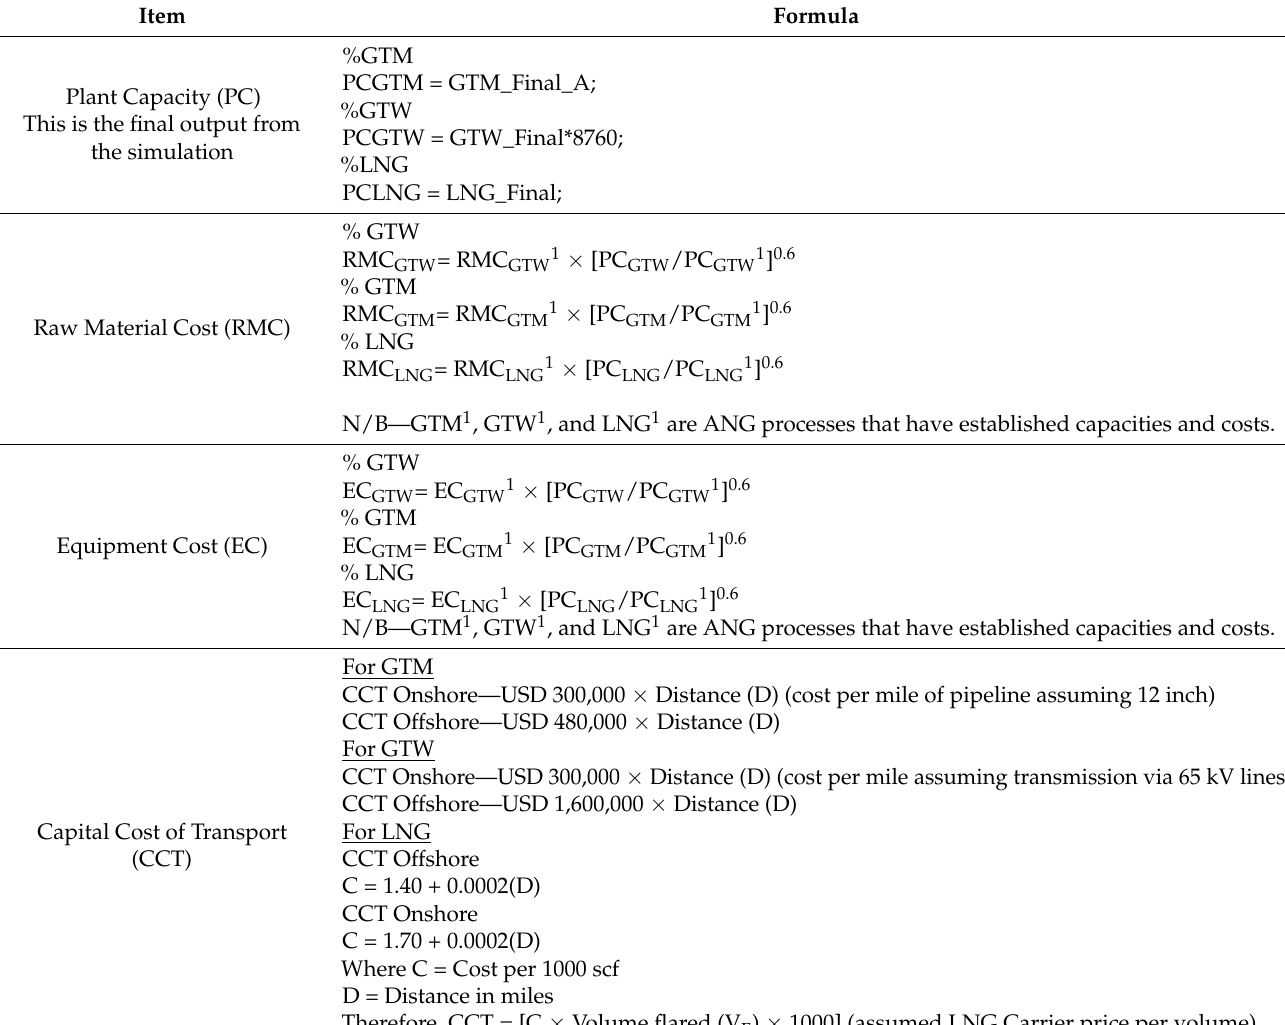
Table A3. Other economic formulas (authors’ construction based on